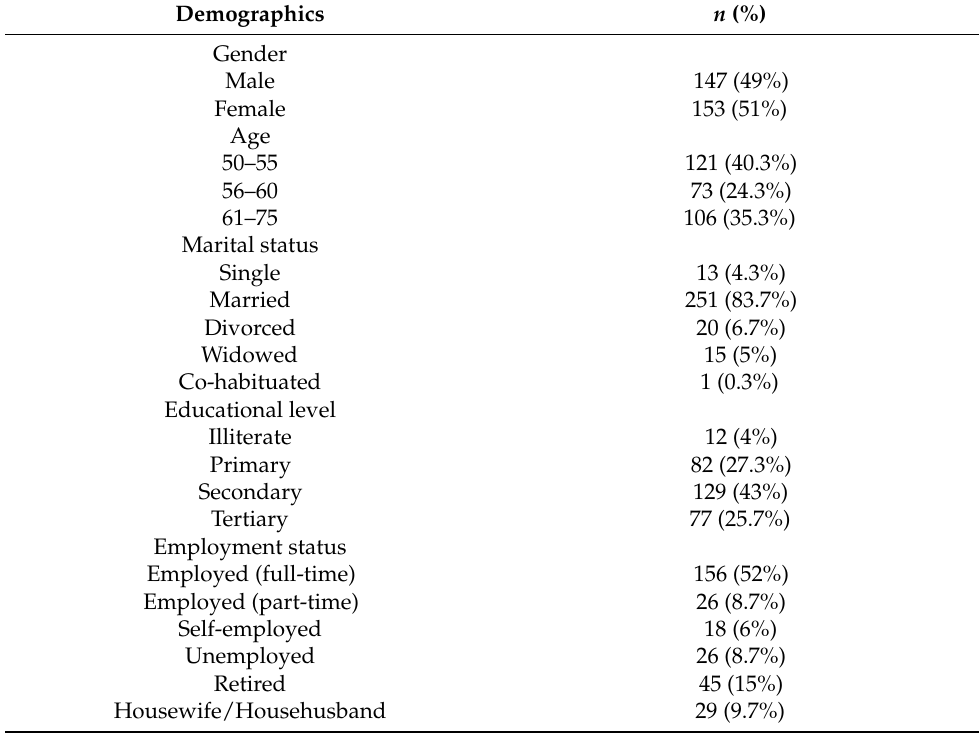
Table 1. Demographics and general CRCSP-related information ( n =